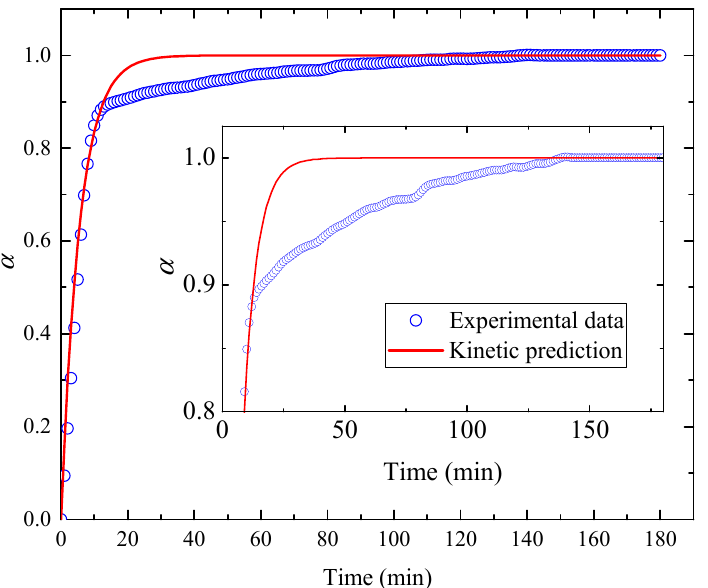
Figure 6. Kinetic prediction of the thermal decomposition of wood from an apple tree at a temperature of 260 °C.